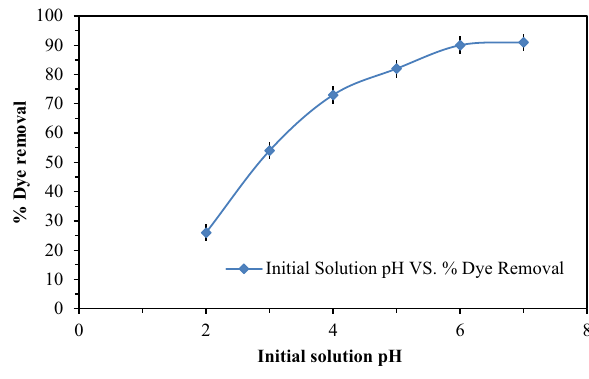
Fig. 4 Percentage removal of MR by SCTJF against pH variation